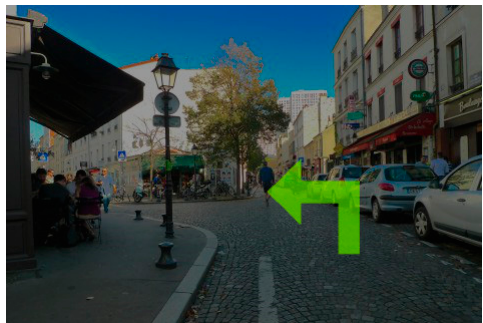
Figure 5. Green arrow inlayed in the field of view through the AR glasses